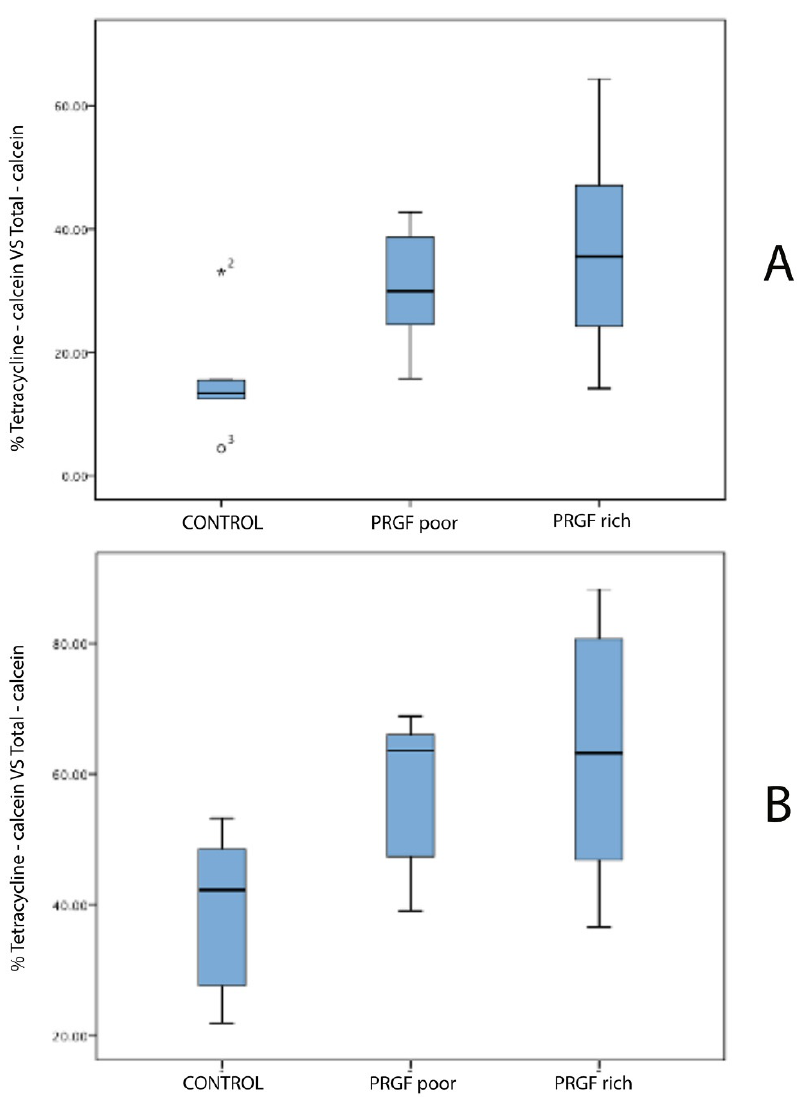
Figure 4. Bar graphs of median of the percentages for ( A , B ) sections with the different